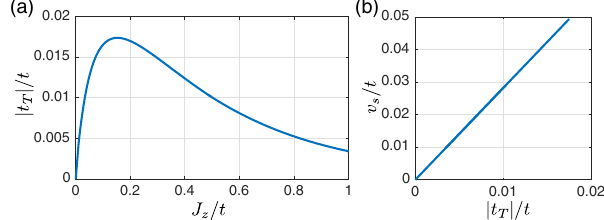
FIG. 17. In the t - J model the spinon velocity v is determined z s by the Trugman loop hopping element t of the spinon, shown for T various J / t and S ¼ 1 /2 in (a). The spinon velocity v , defined by z s FIG. 18. Adiabatic preparation of the rovibrational ground state the rms radius of the spinon density distribution, is directly of the holon. We start from a hole which is localized in the center proportional to t (b). T by a pinning potential of strength g . The latter is decreased over a time τ ¼ 5 / t (inset) and the overlaps of the holon state with the vibrational eigenstates of the magnetic polaron are calculated. We used LST for S ¼ 1 /2 and neglected spinon dynamics. This is justified for the considered value J coupling